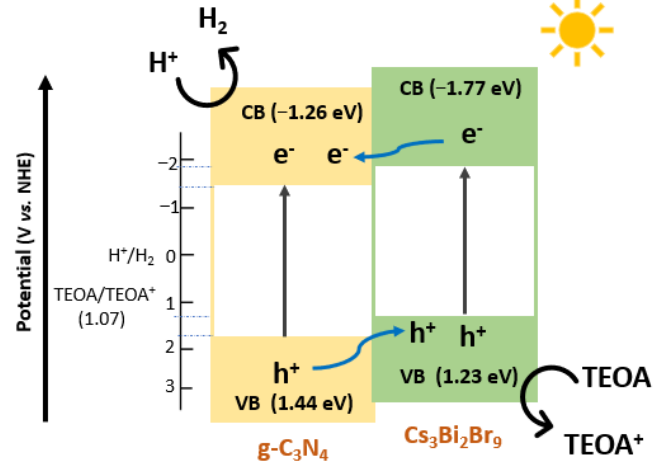
Figure 6. Diagram of charge transfer in the Cs 3 Bi 2 Br 9 NCs/g ‐ C 3 N 4 NSs heterojunction for the photo ‐ catalytic H 2 production under solar radiation. photocatalytic H 2 production under solar